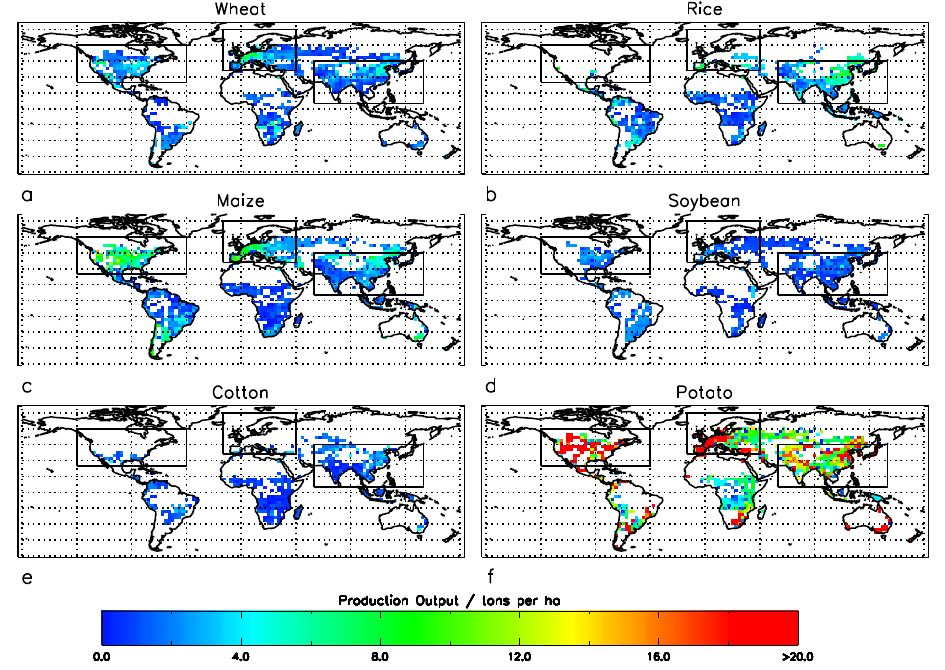
Fig. 1. SAGE group derived crop locations and production output for the six crop types considered, with emissions reduction regions (N America, Europe and SE Asia)